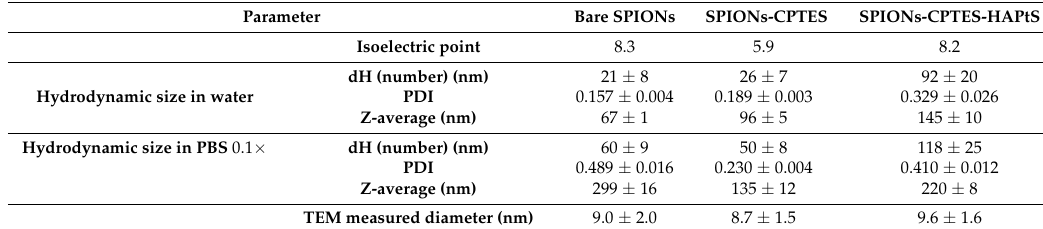
Table 3. Physico-chemical characteristics of bare and modified